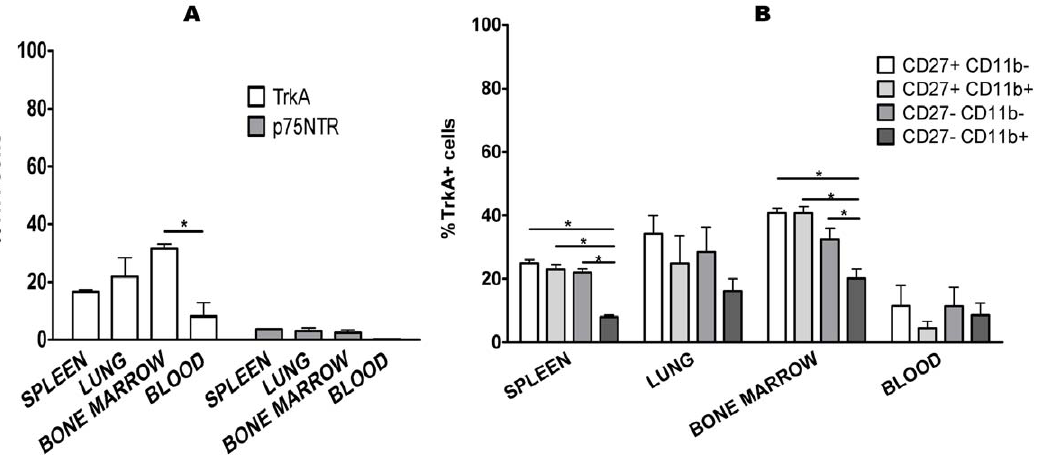
Figure 4. Expression of TrkA on NK cells is different depending on the organs and the NK cell subpopulation. A: NK cells (CD3-NK1.1 + ) from spleen, lung, bone marrow and peripheral blood were stained with anti-TrkA and anti-p75 NTR Ab and analyzed by flow cytometry. Dead cells were excluded by staining with Live Dead cell marker. The percentage of TrkA + NK cells is highest in bone marrow and lowest in blood, whereas p75 NTR was expressed only on 3% of NK cells from spleen, lung and bone marrow. B: NK cells (CD3-NK1.1 + ) from the above mentioned organs were subdivided on the basis of the relative expression of CD27 and CD11b. TrkA expression is lowest on the CD27-CD11b + population. The data shown are the means 6 SEM of three experiments. *: p , 0.05.